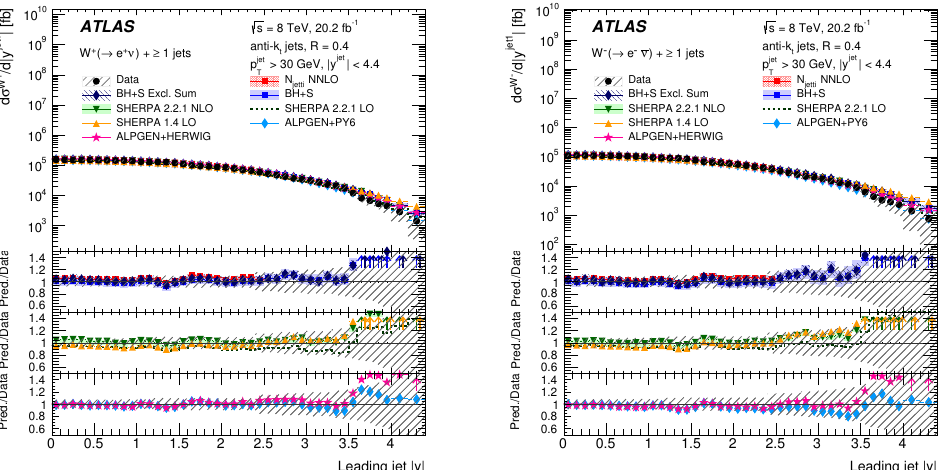
Figure 20 . Di(cid:11)erential cross sections for the production of W + (left) and W (cid:0) (right) as a function of the leading jet rapidity for events with N jets (cid:21) 1. For the data, the statistical uncertainties are indicated as vertical bars, and the combined statistical and systematic uncertainties are shown by the hatched bands. The uppermost panel in each plot shows the di(cid:11)erential cross sections, while the lower panels show the ratios of the predictions to the data. The theoretical uncertainties on the predictions are described in the text. The arrows on the lower panels indicate points that are outside the displayed range.